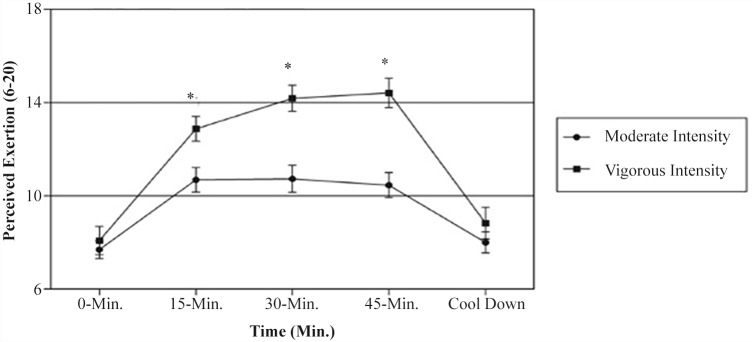
Perceived exertion responses to the two exercise intensity trials.Data are shown as means ± standard error. * p < 0.01, moderate-exercise intensity significantly different from vigorous-exercise intensity.